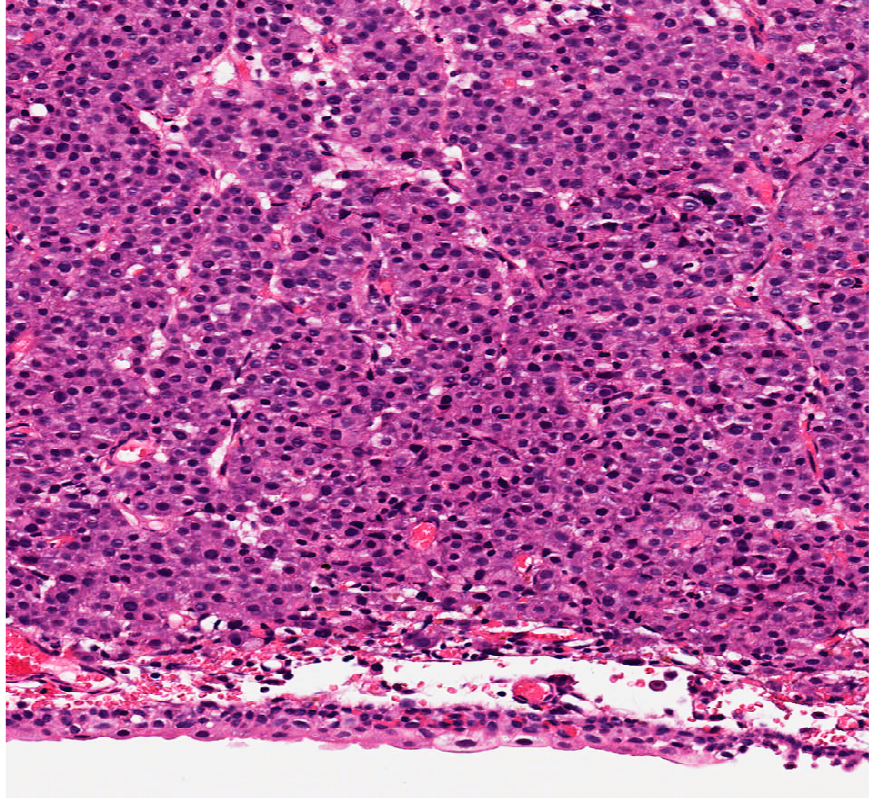
Figure 2. Aggressive variant